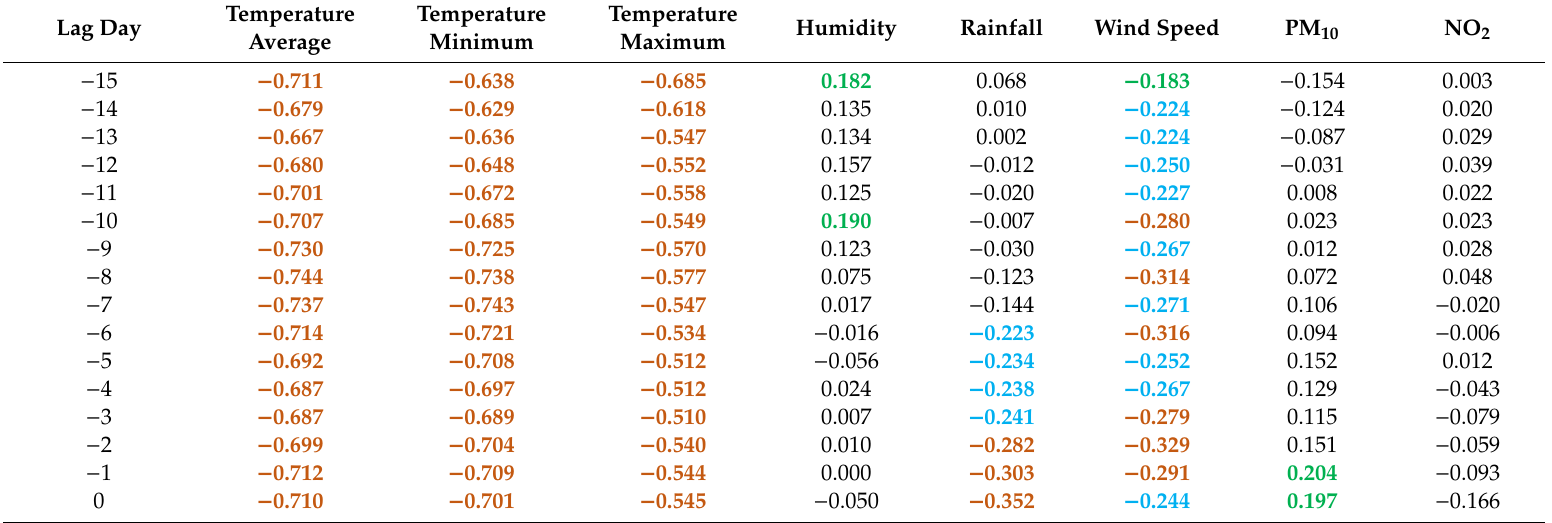
Table A2. Empirical results through Spearman rank correlation test for new cases in CABA, from lag of 15 days prior to the confirmation date (lag 0). Number colors indicate stands for 1% , 5% , and 10% level of significance,